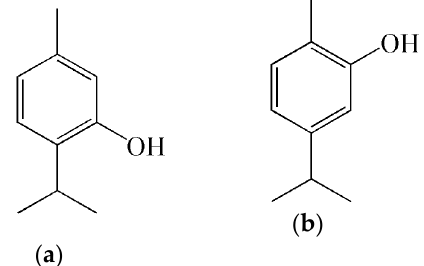
Figure 2. Chemical structure of thymol ( a ) and carvacrol ( b ).